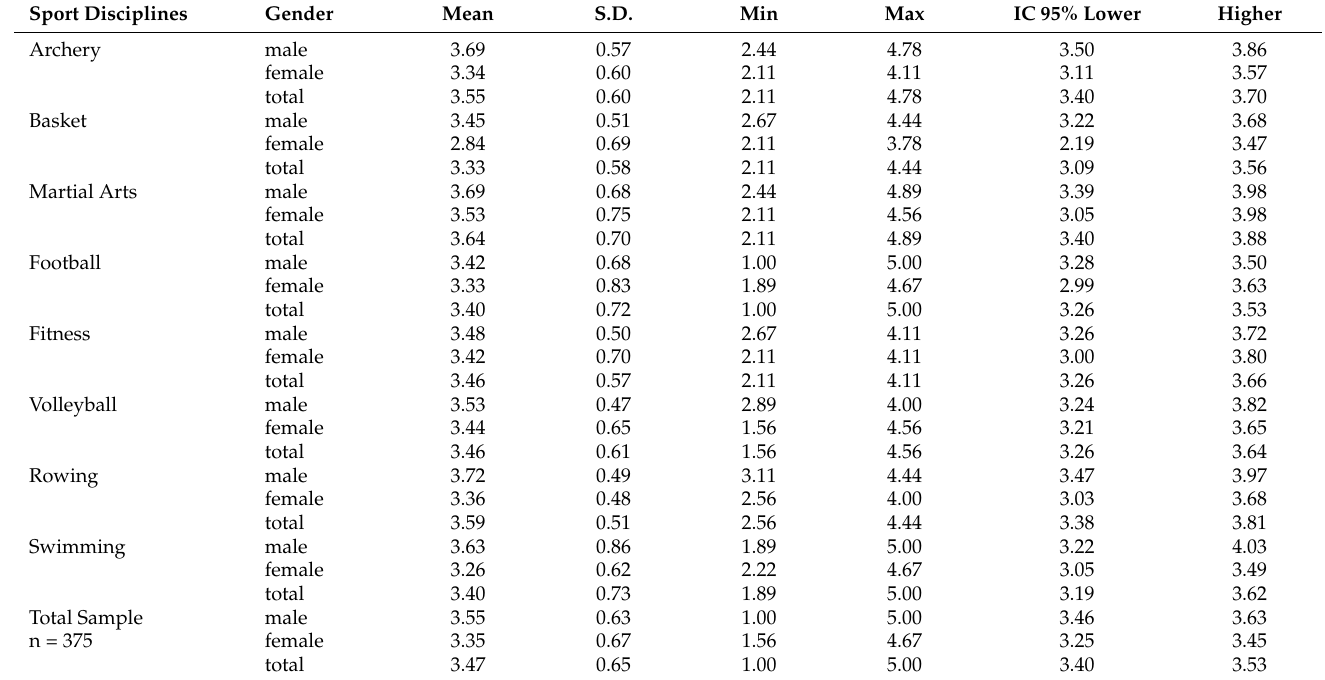
Table 2. DSS scores considering sport discipline and athletes’